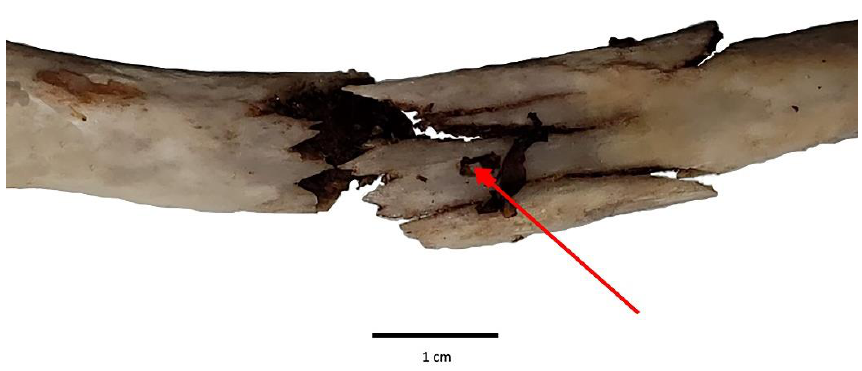
Figure 4. Class 1 experimental chop mark made by the ground stone axe on a pig rib (cBI 91) with uncontrolled breakage and crushing at the place of impact (arrow indicates the place of